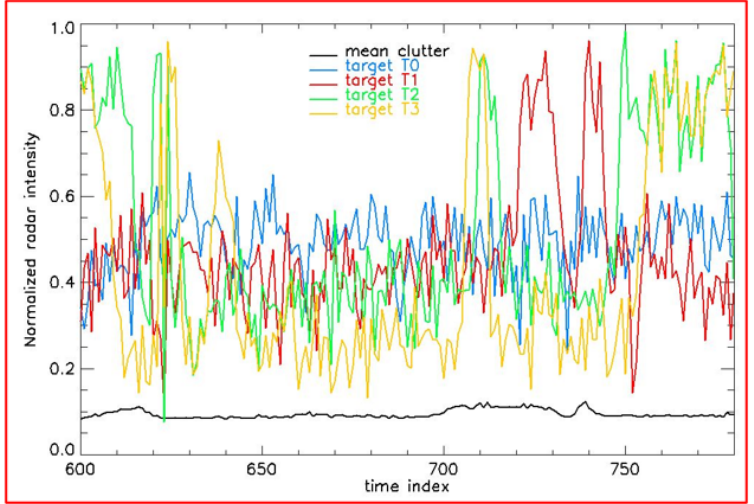
Figure 11. Radar intensities of the targets related to the second release .